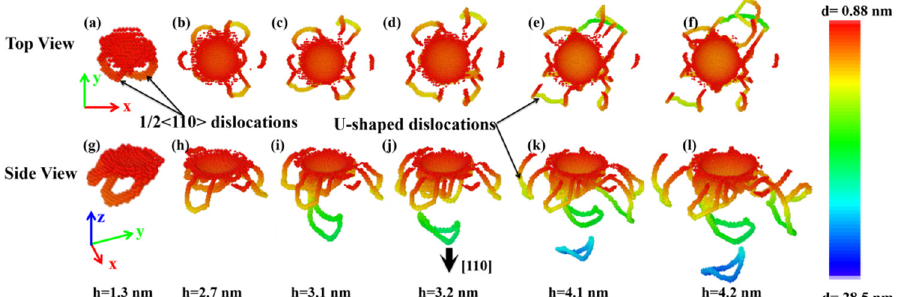
Figure 10. The microstructure evolution under the indented (110) plane of ZnSe nano film at different indentation depth. Atoms are colored with z-value. ( a ), ( b ), ( c ), ( d ), ( e ), and ( f ) are the top views of the structures at the indentation depth of 1.3 nm, 2.7 nm, 3.1 nm, 3.2 nm, 4.1 nm, and 4.2 nm, respectively. ( g ), ( h ), ( i ), ( j ), ( k ), and ( l ) are the side views of the structures at the indentation depth of 1.3 nm, 2.7 nm, 3.1 nm, 3.2 nm, 4.1 nm, and 4.2 nm, respectively.